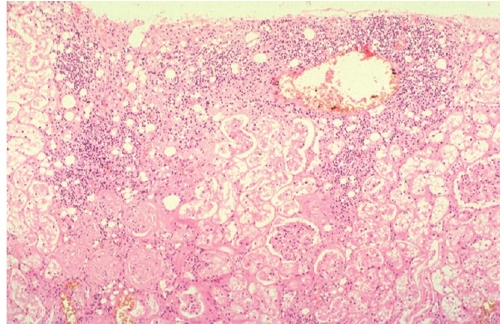
Figure 6: Kidney of a cat with FIP. Severe degenerative and advanced necrotic changes within the lining endothelium of the convoluted tubules (mostly cytoplasmolysis). Frank patchy intersti- tial nephritis, as indicated by the heavy infiltration of lymphocytes, plasma cells and some dead neutrophils, together with dilatation and congestion of the interstitial blood vessels. The photograph was kindly provided by Dr. Diane